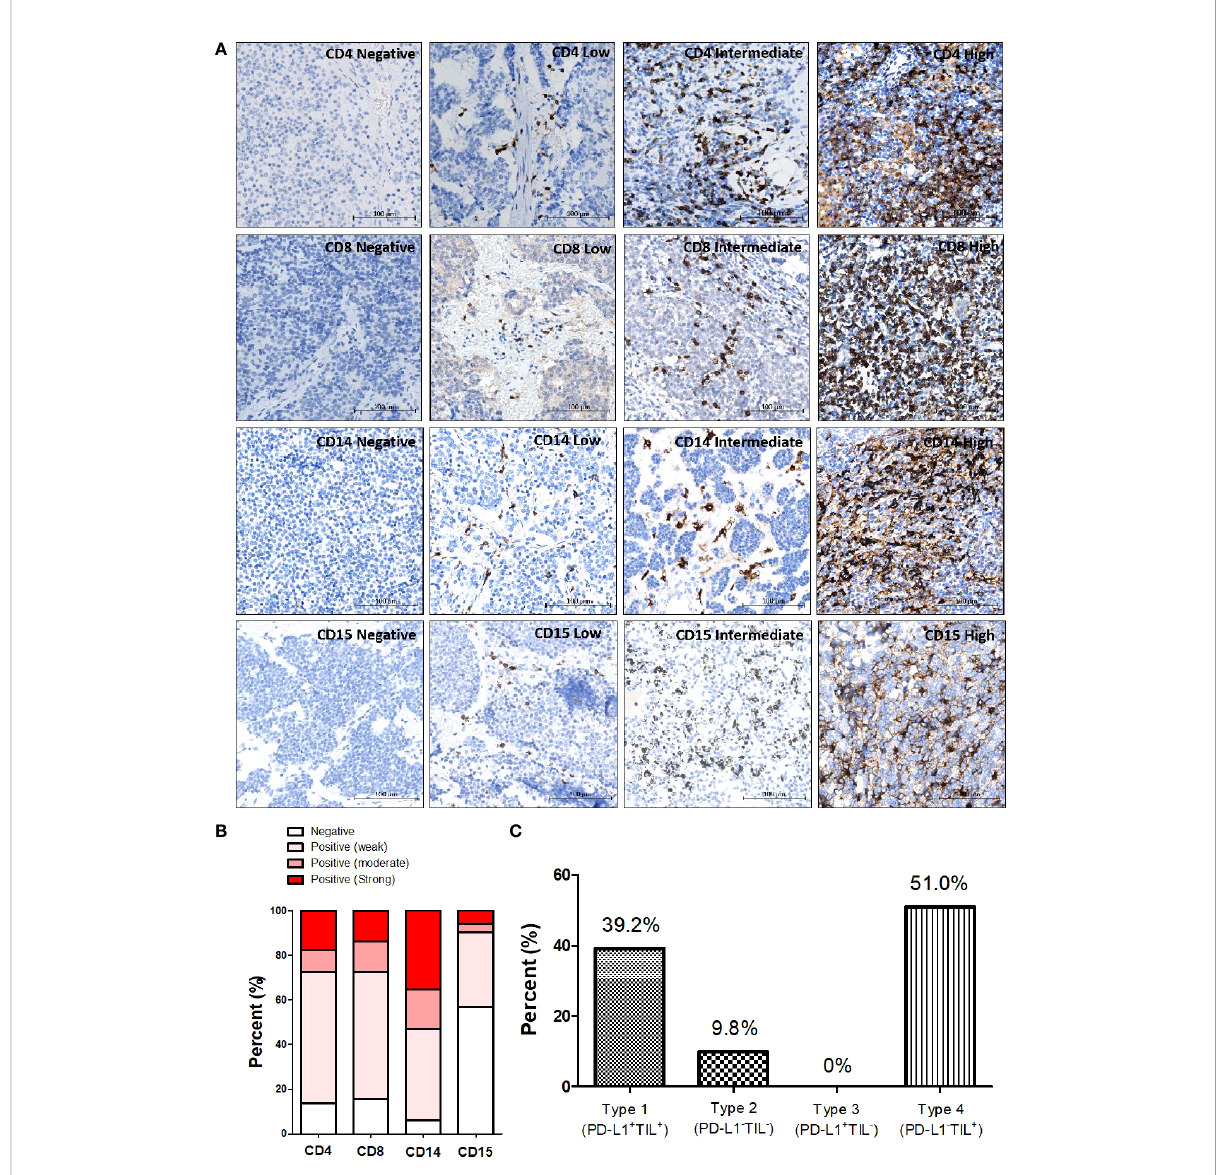
FIGURE 2 Patterns of different immune cell in fi ltrations in T-NEN. (A) Different in fi ltration levels of CD4 + TILs, CD8 + TILs, CD14 + monocytes, and CD15 + granulocytes in T-NEN are shown with representative IHC-stained images. (B) Proportion of strati fi ed immune cell in fi ltration levels in T-NEN is displayed. (C) Classi fi cation of the immune landscape according to the PD-L1 overall/TILs pattern in